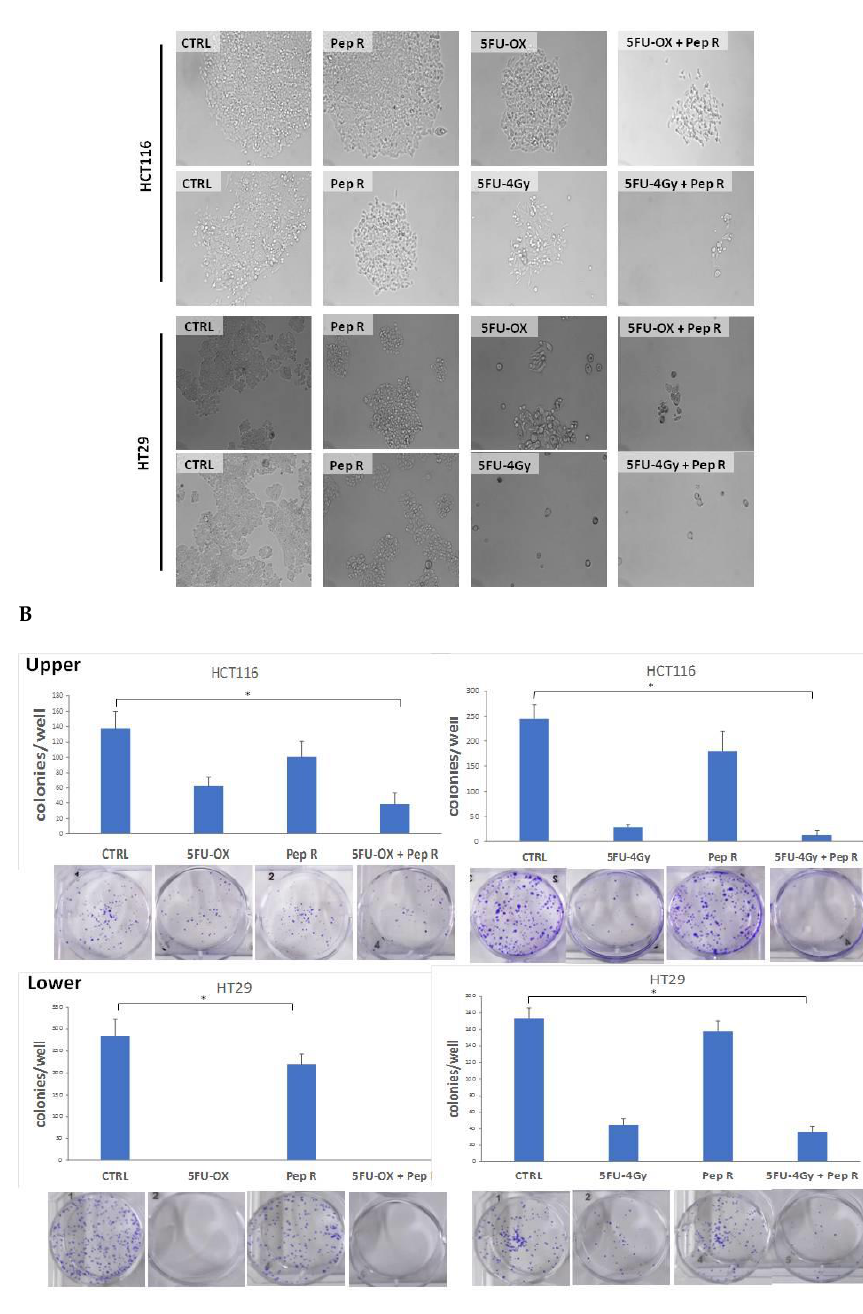
Figure 4. Peptide R rescued CT/ RT-CT sensitivity. ( A ) Microphotograph of HCT116 ( A upper panel ) and HT29 ( A lower panel ), untreated cells and after treatment with CT/RT-CT plus Pep R. (10 × magnification); ( B ) HCT116 ( B Upper ) and HT29 ( B Lower ) cell line were evaluated for clonal capability. Representative well plate images for each treatment are shown below the bar graph. Bar graphs show clone number (mean ± SD) for each treatment. A p -value < 0.05 (*) was considered statistically significant (Kruskal- Wallis test followed by Dunn’s multiple comparison ).